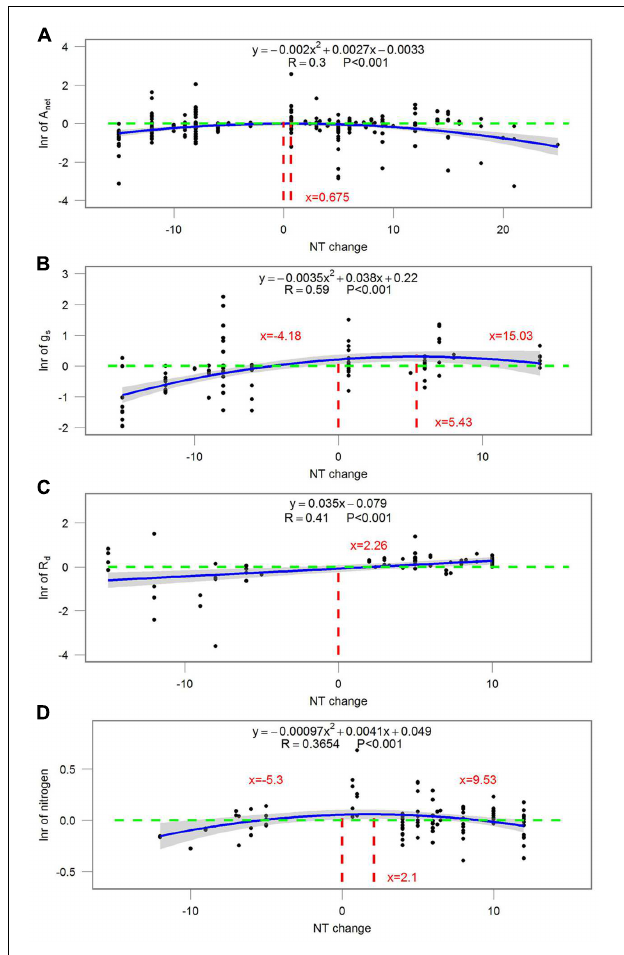
FIGURE 7 | Correlations between the magnitude of NT treatment and the response ratio of (A) net photosynthetic rate ( A net ); (B) stomatal conductance ( g s ); (C) dark respiration rate ( R d ) and (D) tissue nitrogen content (N). Each point represents response ratio (lnr) to HNT or LNT. Regression function, variation coefficient and p -value are presented in the middle of each graph. Different lines indicate X = 0 (red line), x -value when y is the maximum, crossing points of y = 0 (green line) and regression relationships. Note that N is tissue nitrogen content including stem, leaf, panicle, spike, grain, shoot, root, and total